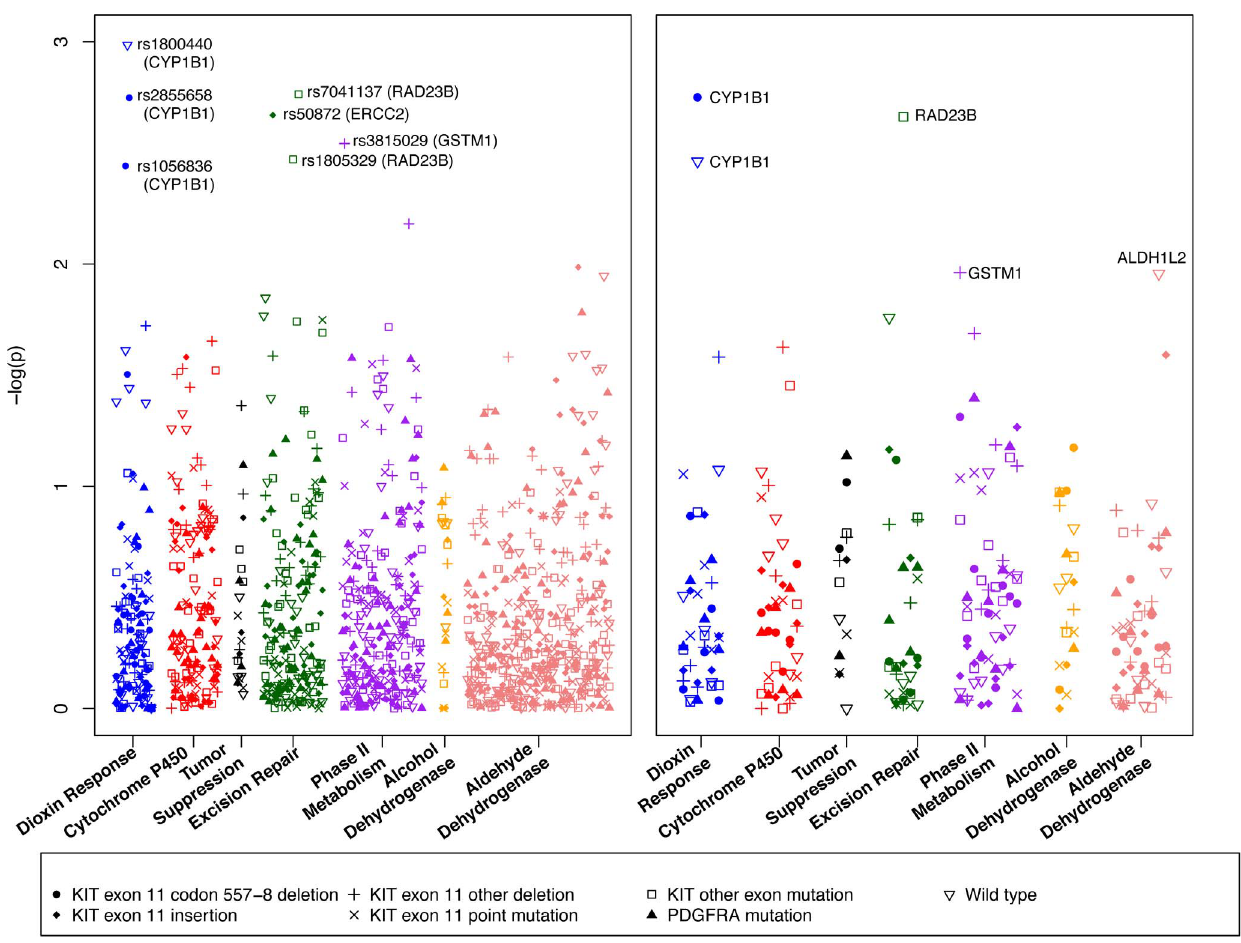
Figure 1. Log p-values for individual variant (left) and SKAT (right) analyses by functional group and tumor mutation type.